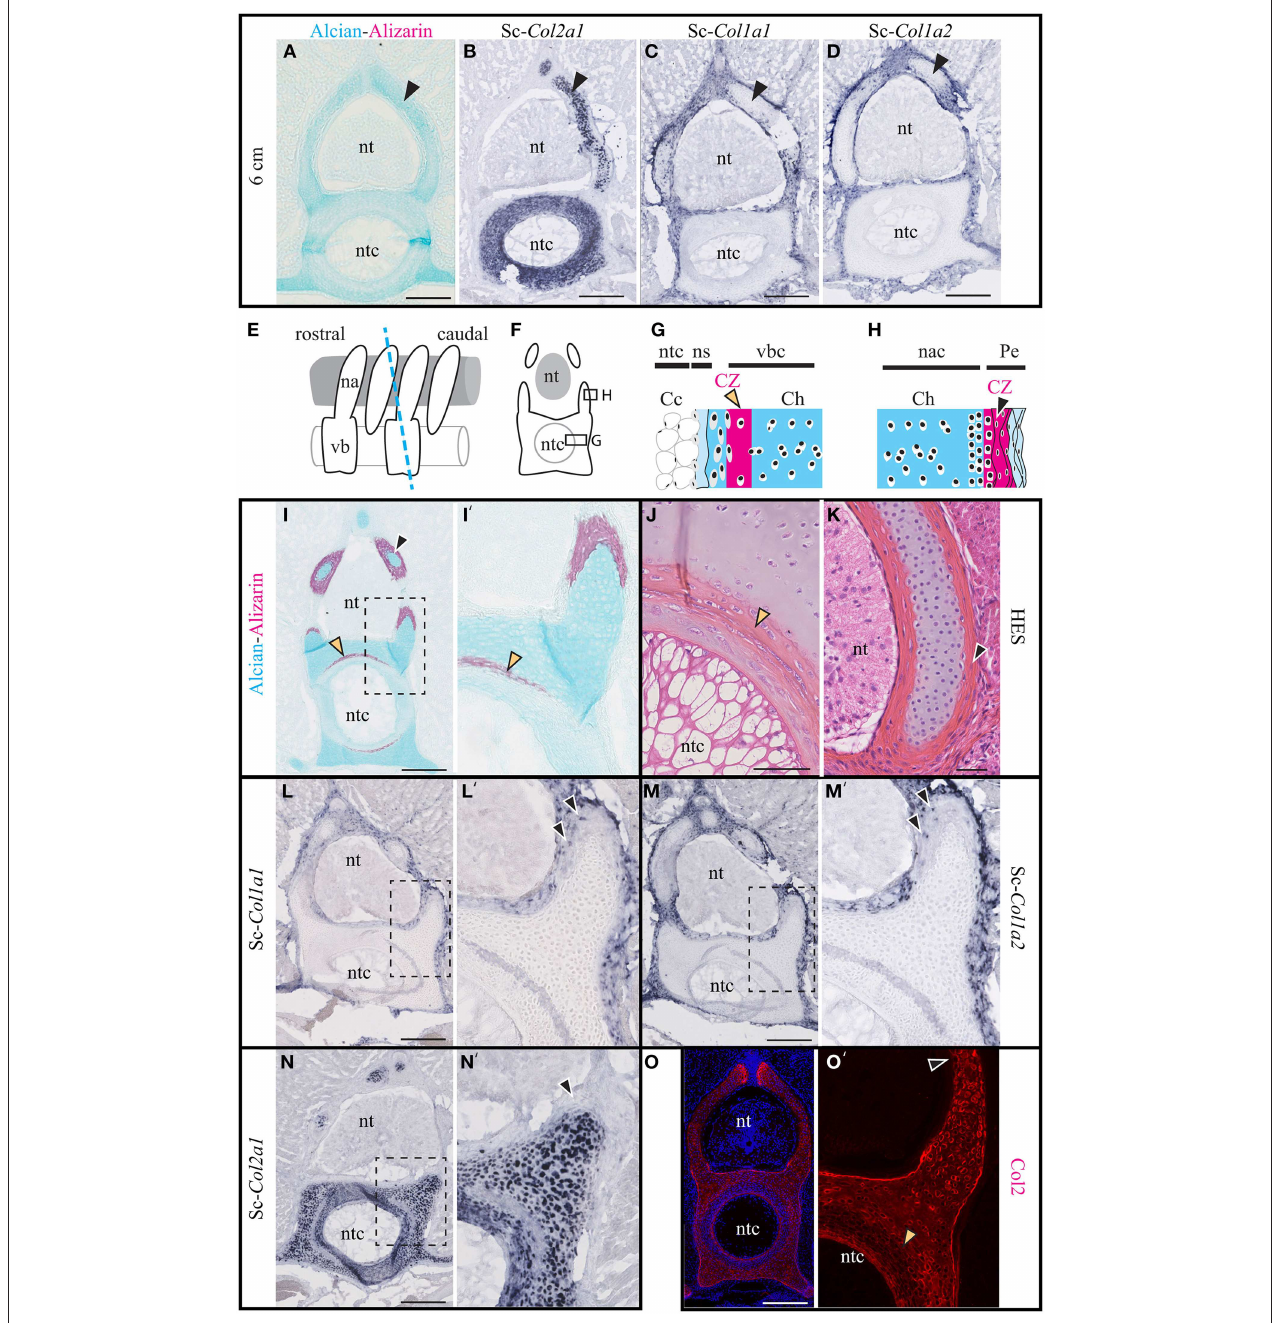
FIGURE 2 | Cartilage calcification and collagen expression in Scyliorhinus canicula vertebrae. (A–D) Transverse sections of the vertebrae of 6cm-long embryos (black arrowheads show the hyaline cartilage of the neural arches). (A) Alcian blue and Alizarin red double staining revealing the distribution of the hyaline cartilage and the absence of detectable calcification. (B–D) In situ hybridizations showing the expression of Sc- Col2a1 , Sc- Col1a1, and Sc- Col1a2 , as indicated. (E) Schematic drawing of the vertebral anatomy from 9cm-long S.c. embryos (lateral view) and of the orientation of the transverse sections (blue dotted line) represented in (F) and shown in (I–O’) . (G) General histology of the centrum. (H) General histology of the neural arches. (I) Alizarin red and Alcian blue double staining. (J,K) HES staining of the centrum and of the neural arch. (L–N) In situ hybridizations showing the expression of Sc- Col2a1 , Sc- Col1a1, and Sc- Col1a2 , as indicated. Arrowheads in (L’,M’) indicate scattered Sc- Col1a1 and Sc- Col1a2 positive cells embedded in the calcified layer of the neural arches. (O) Immunofluorescence using an anti-Type II collagen (Col2) specific antibody. Higher magnifications of (I,L–O) are shown in (I’,L’–O’) respectively. Orange and black arrowheads show the calcifying matrix of the centrum and neural arches, respectively. Cc, chordocytes; Ch, chondroctyces; na, neural arch; nac, neural arch cartilage; ns, notochord sheath; nt, neural tube; ntc, notochord core; Pe, perichondrium; vb, vertebral body; vbc, vertebral body cartilage. Insets in (L–O) are shown at higher magnification in (L’–O’) , respectively. Scale bars: (A–D) 250 µ m; (I,L–O) 200 µ m; (J,K) 50 µ m.